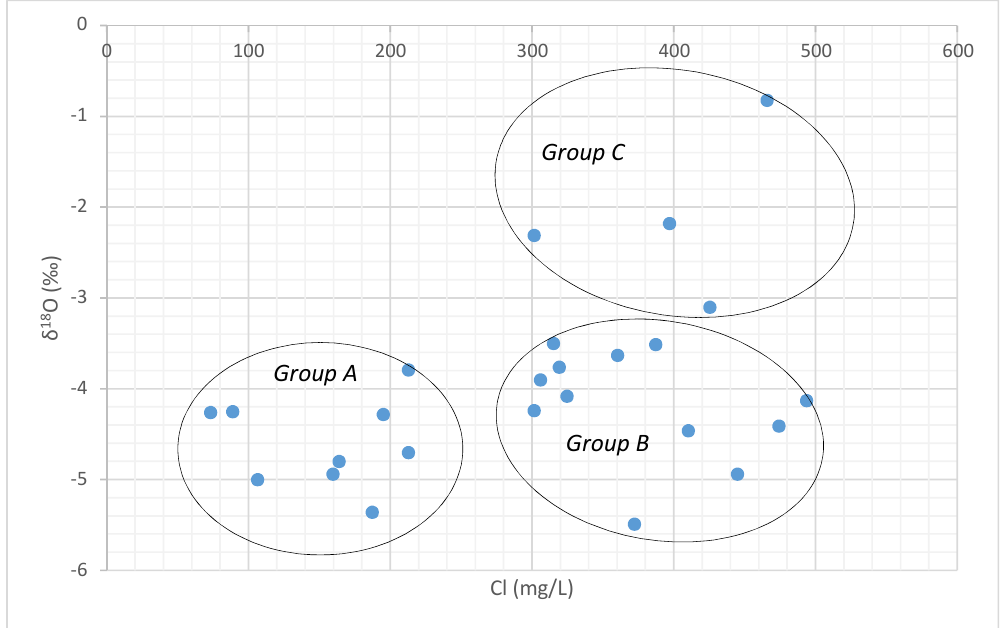
Figure 11. Chloride vs. δ 18 O plot.